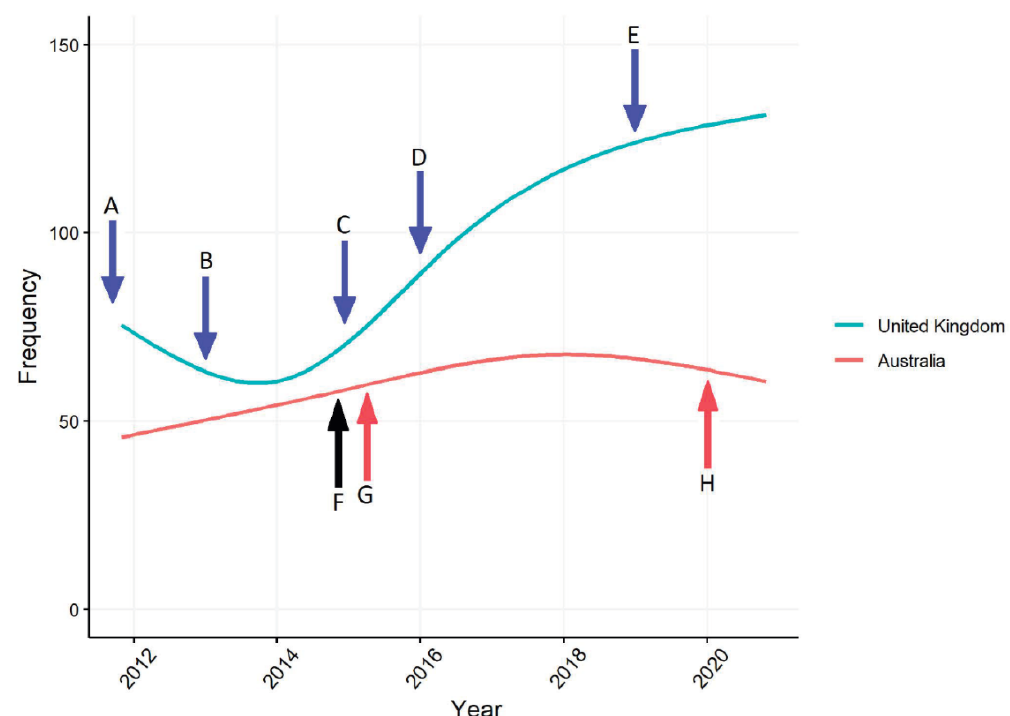
Figure 1. Frequency of articles on AMR in Australia and UK between 2011 and 2020. Figure key: (A) Annual Report of the Chief Medical Officer, Vol 2, 2011 [8]; (B) UK Five Year AMR Strategy 2013–18 [23]; (C) UK AMR Funder’s Forum established; (D) The O’Neil Review on Antimicrobial Resistance 2014 [11]; (E)—The UK’s Five-year National Action Plan. 2019 [29]; (F) The WHO Global Action Plan [56]; (G) Australia’s First National Antimicrobial Resistance Strategy 2015–2019 [26]; (H) Australia’s National Antimicrobial Resistance Strategy—2020 and beyond [30].